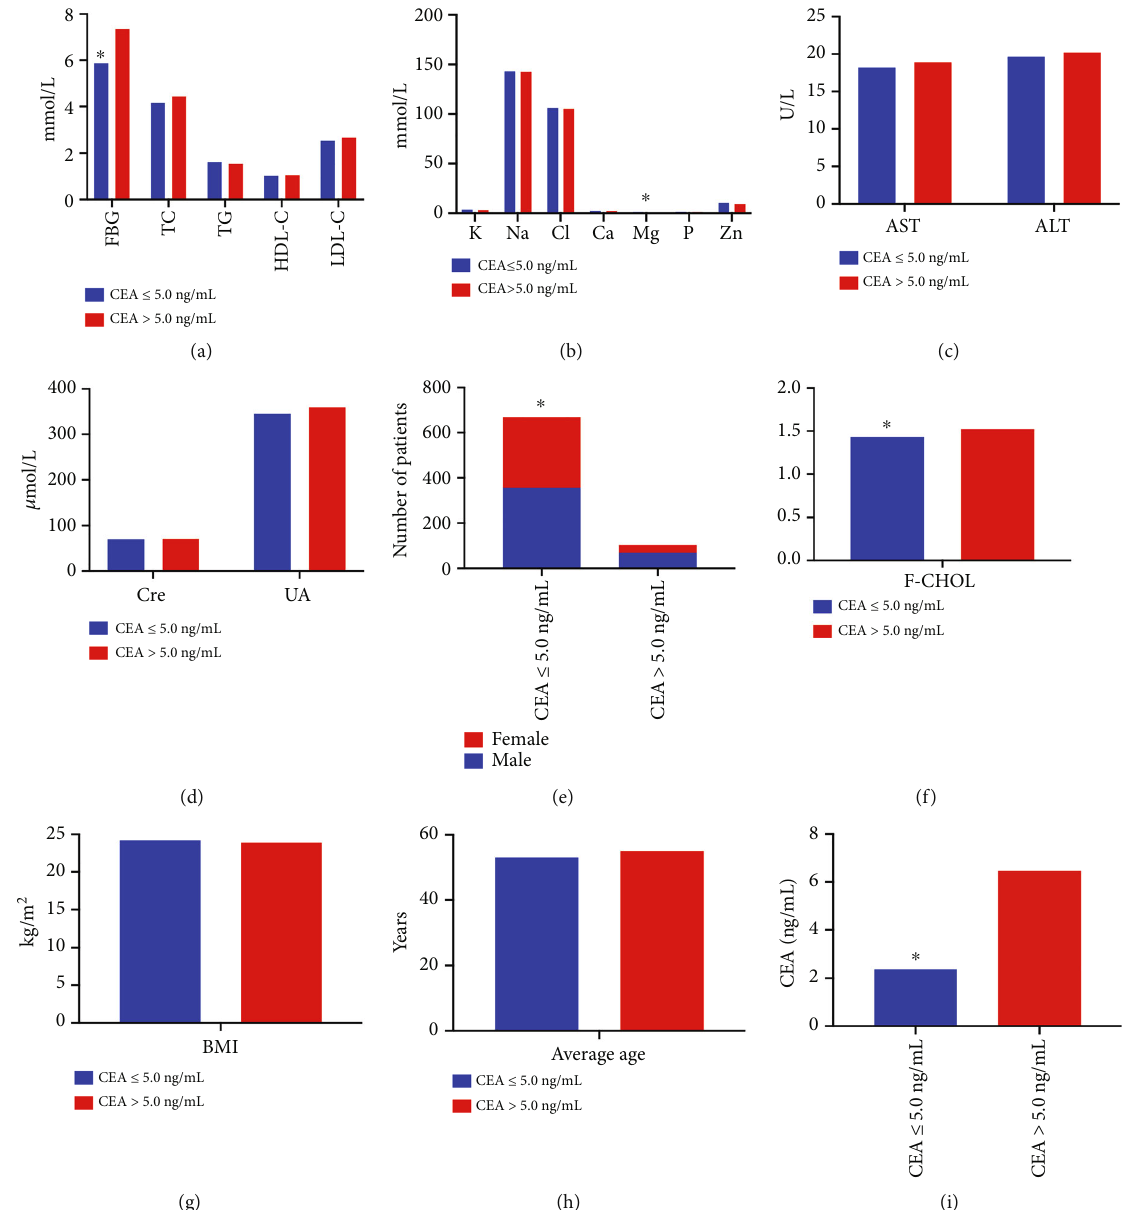
Figure 7: Comparison of di ff erent indicators between the CEA ≤ 5 : 0ng/mL and CEA > 5 : 0ng/mL groups. (a) Comparison of levels of FBG, TC, TG, HDL-C, and LDL-C between the two groups. Compared with the CEA > 5 : 0 ng/mL group, the levels of FBG were signi fi cantly lower in CEA ≤ 5 : 0ng/mL group. (b) Comparison of levels of K, Na, Cl, Ca, Mg, P, and Zn in the blood between the two groups. (c) Comparison of AST and ALT levels between the groups. (d) Comparison of Cre and UA levels between the groups. (e) Comparison of the number of male and female patients between the groups. (f) The F-CHOL in CEA ≤ 5 : 0ng/mL group was signi fi cantly lower than in CEA > 5 : 0 ng/mL group. (g) Comparison of BMI of patients between the groups. (h) Comparison of average age of patients between the groups. (i) The blood CEA in CEA ≤ 5 : 0ng/mL group was signi fi cantly lower than in CEA > 5 : 0 ng/mL